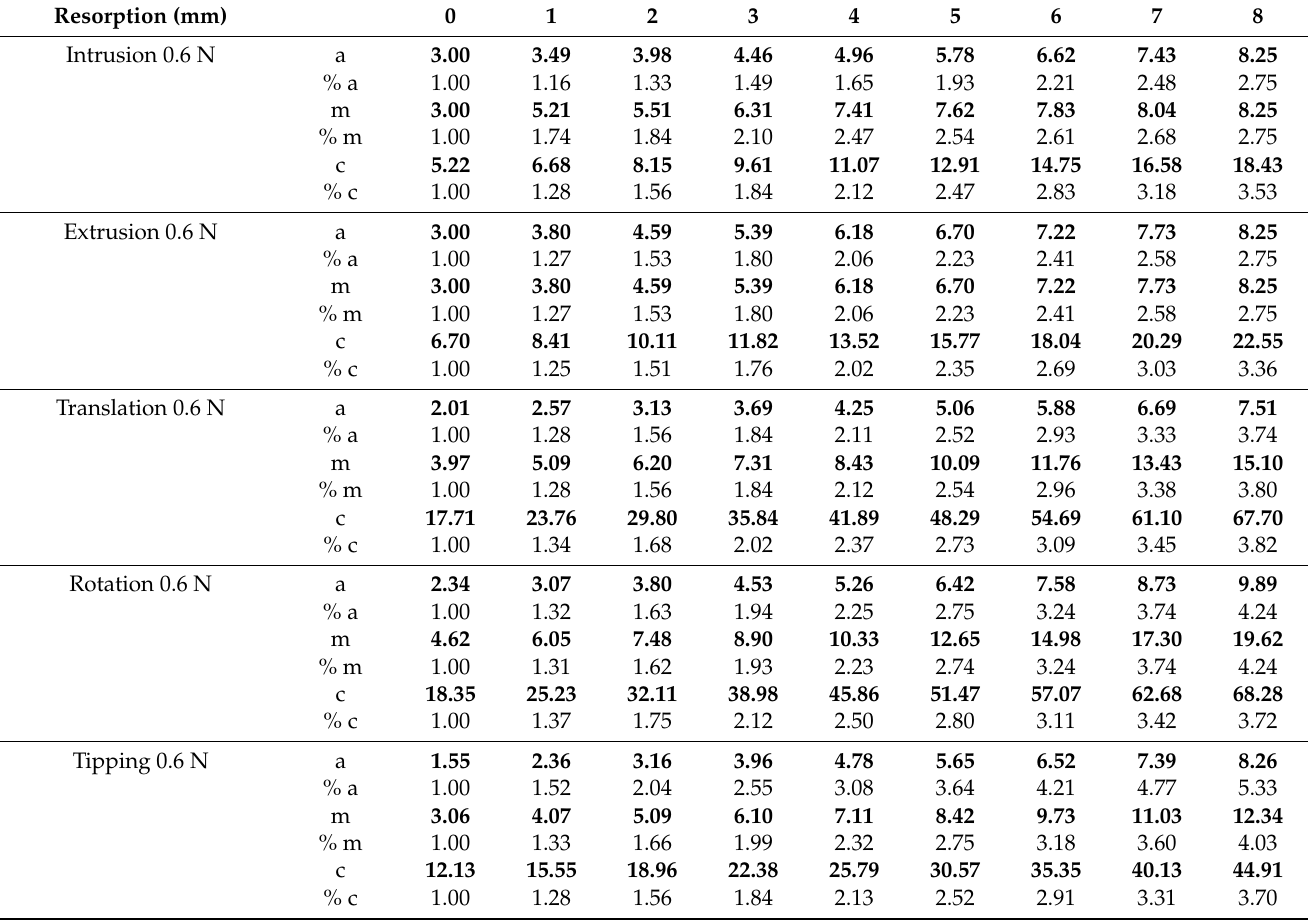
Table 2. The Tresca shear stress average values (KPa) produced by 0.6 N of orthodontic